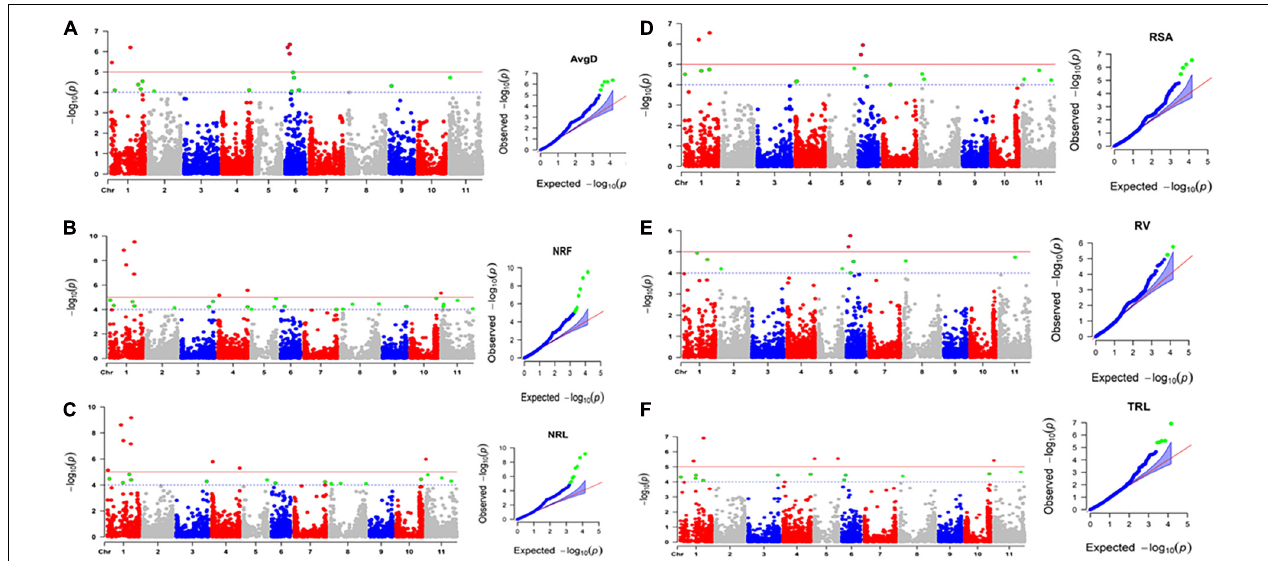
FIGURE 3 | Manhattan and QQ plots of genome wide association study (GWAS) results of Average root diameter (A) , Number of root forks (B) , number of root links (C) , Root surface area (D) , Root volume (E) , and Total root length (F) , where single nucleotide polymorphism (SNP) loci are ordered by physical position and grouped by chromosome. The black dash line indicates the genome wide significance threshold. The SNP loci highlighted in red were significant with a given trait at p -values lower than the Bonferroni corrected significance cut-off value for number of independent tests which was p = 1 × 10 - 5 .